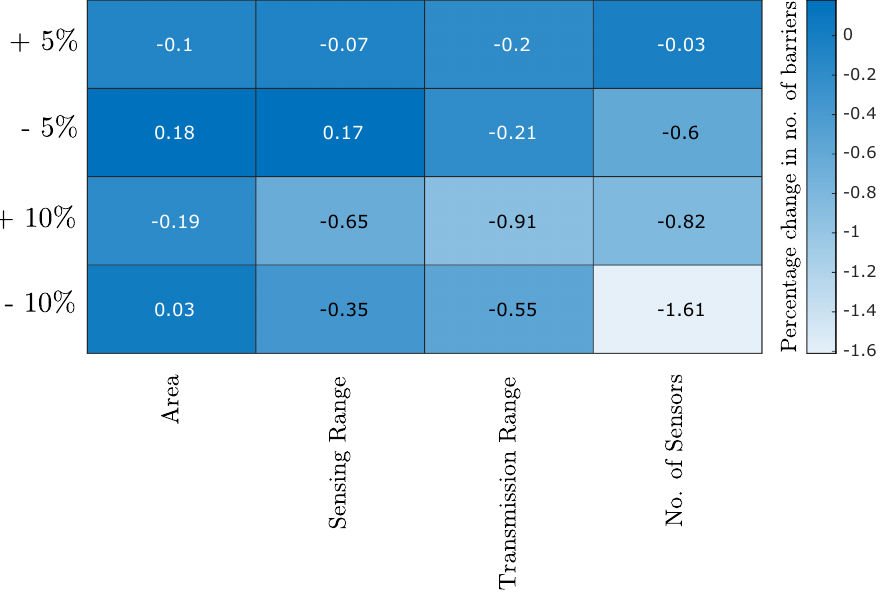
Figure 7. Sensitivity analysis of LT − ZM − SVR for ± 5% and ± 10% uncertainty in the input